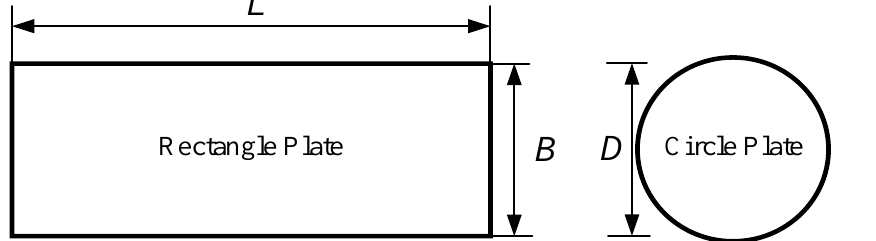
Figure 19. Schematic diagram of the rectangle plate and the circle plate.